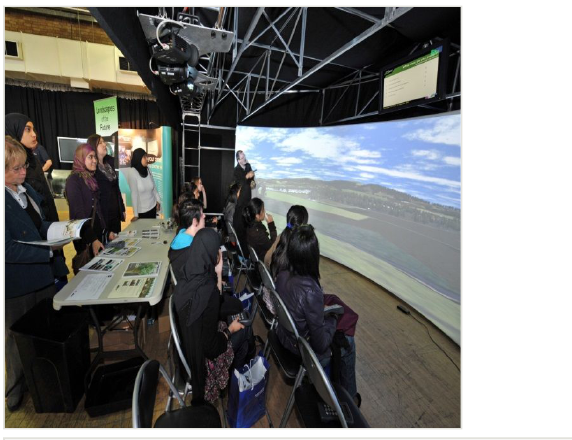
Figure 4. VRT based stakeholder evaluation remotely from the study area (Birmingham, UK).